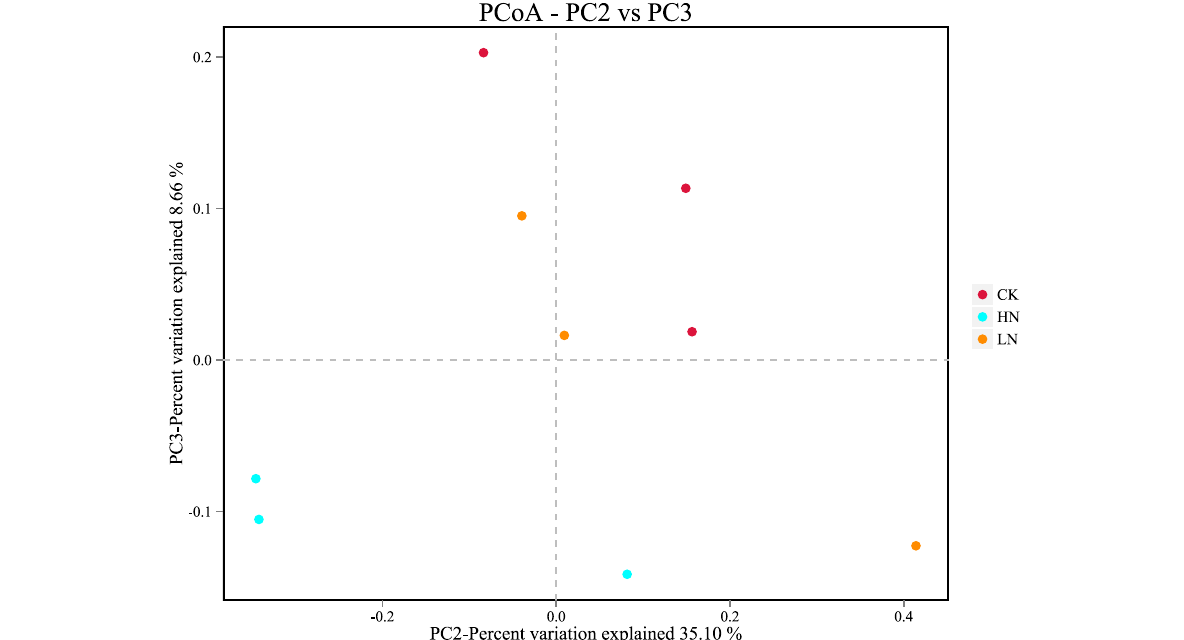
Fig. 1 Principal coordinates analysis (PCoA) of soil bacterial community under different nitrogen deposition treatments. CK, control treatment; LN, low nitrogen treatment; HN, high nitrogen treatment. The β‑diversity was calculated at the OTU level (97%) based on the Bray–Curtis dissimilarity